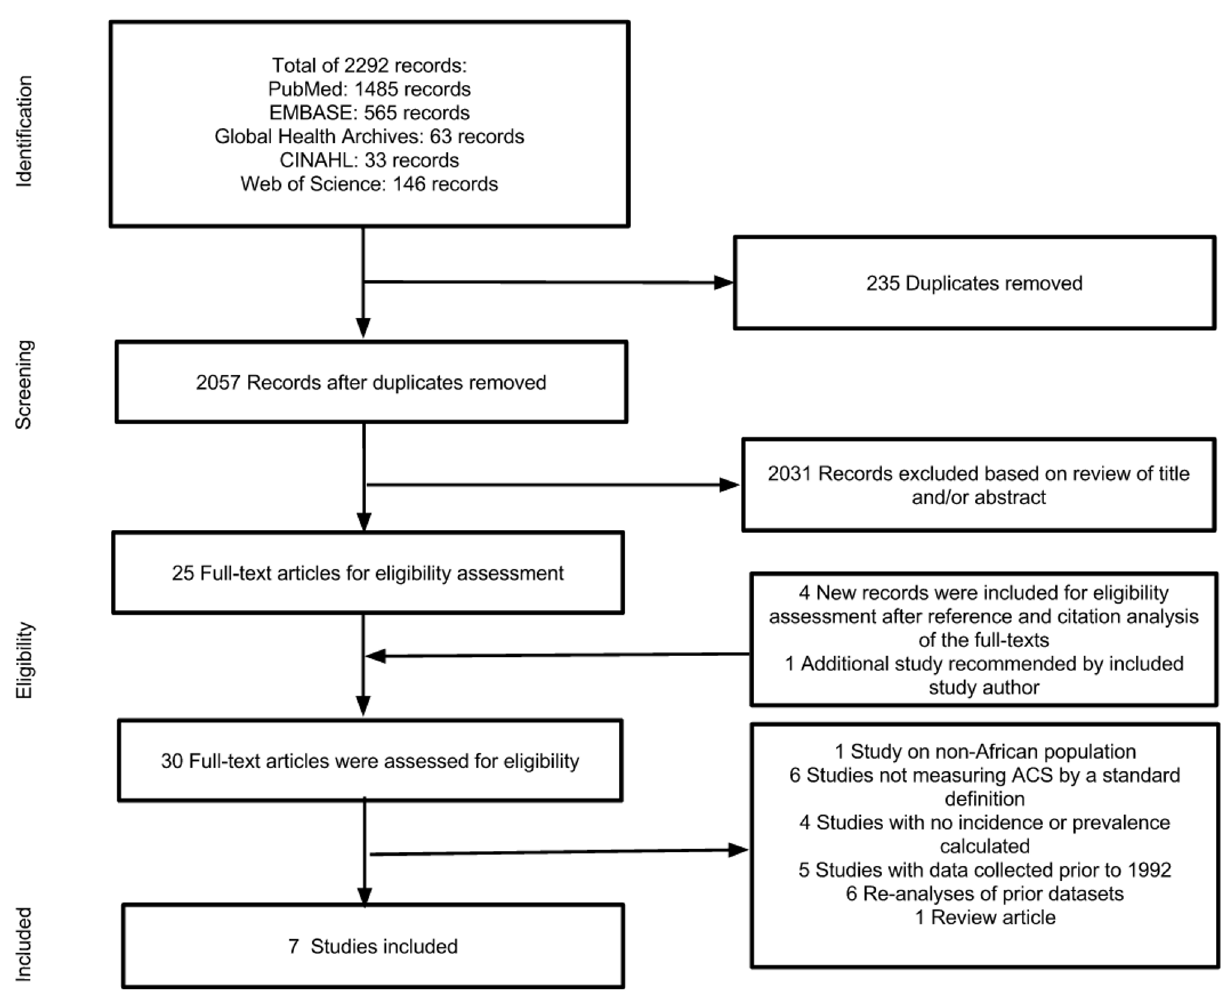
Figure 1. Study flow diagram.